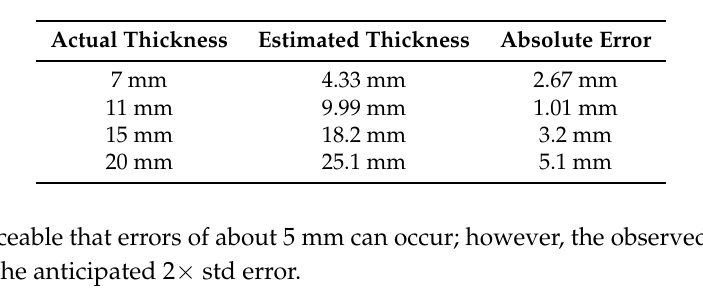
Table 6. GP model accuracy on testing data, i.e., grey cast iron calibration blocks (with 14 mm